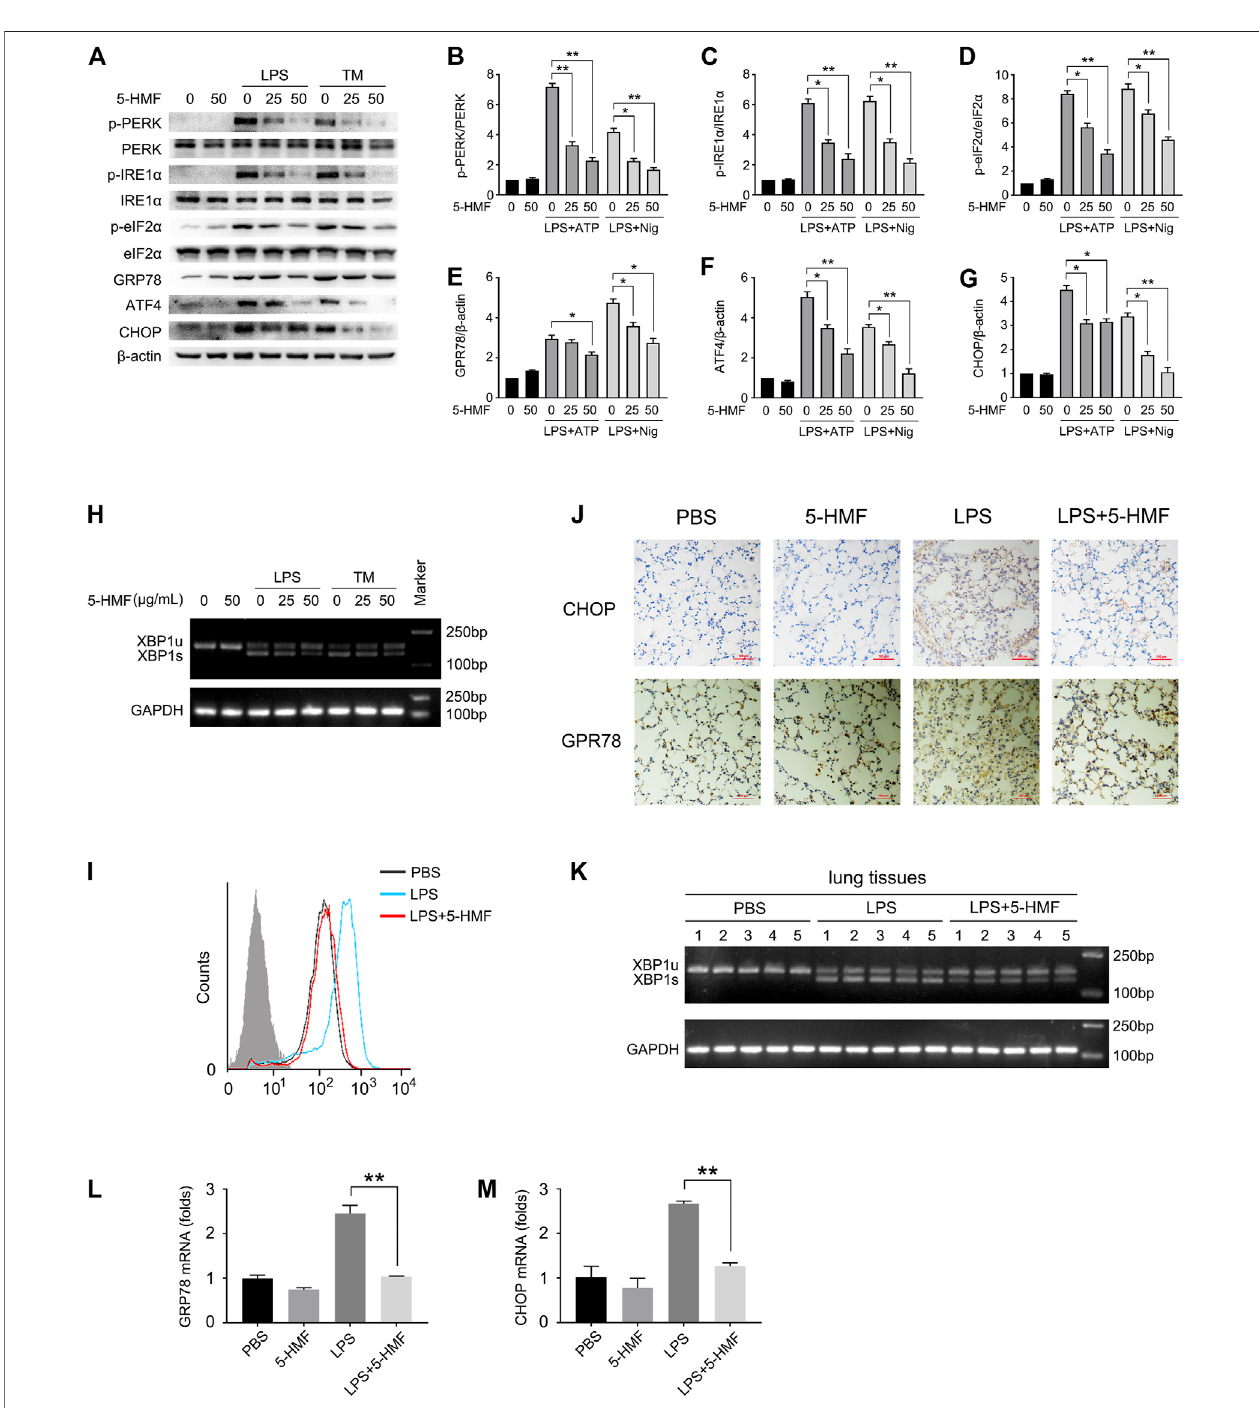
FIGURE 5 | 5-HMF inhibits LPS-triggered ER stress. (A – K) BMDMs pretreated with different concentrations of 5-HMF were challenged with LPS (500 ng/ml) for 6 h or tunicamycin (1 μ g/ml) for 16 h (A – G) Immunoblot showing total and phosphorylated PERK, eIF2 α , IRE-1 α and expression levels of ATF4, GPR78 and CHOP in BMDMs (A) . (B – G) The relative band densities of the phosphorylation of PERK (B) , IRE1 α (C) and eIF2 α (D) , and the expression of GPR78 (E) ATF4 (F) and CHOP (G) . (H) RT-PCRanalysisofXBP1splicinginBMDMscellstreatedwithPBSor5-HMF,followedbyLPSortunicamycinstimulationasindicated. (I) FACSanalysisofthe intracellular Ca 2+ concentrations stained by green fl uorescence (Fluo-3). (J) Representative IHC images showing in-situ expression of CHOP and GPR78 in lung tissues of mice treated as in Figure 1A ( × 200), Scale bar, 100 μ m. (K) RT-PCR analysis of XBP1 splicing in lung tissues of mice treated with PBS or 5-HMF as in Figure 1A , followed by LPS stimulation. (L,M) Chop (L) and Gpr78 (M) mRNA levels in lung tissues of mice treated as in Figure 1A . Data are the mean ± SD of three independent experiments: * and ** indicate p < 0.05 and p < 0.01 respectively by Student ’ s t-test.